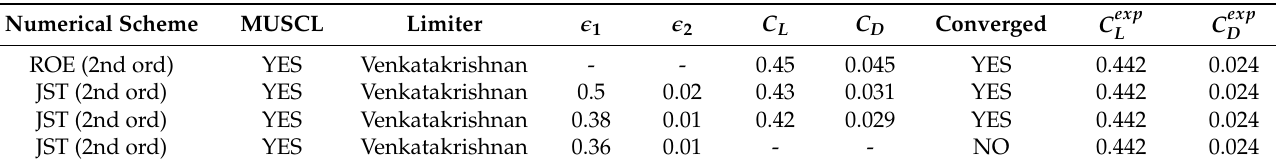
Table 3. Effect of numerical discretization of convective terms α = 8.36 ◦ .